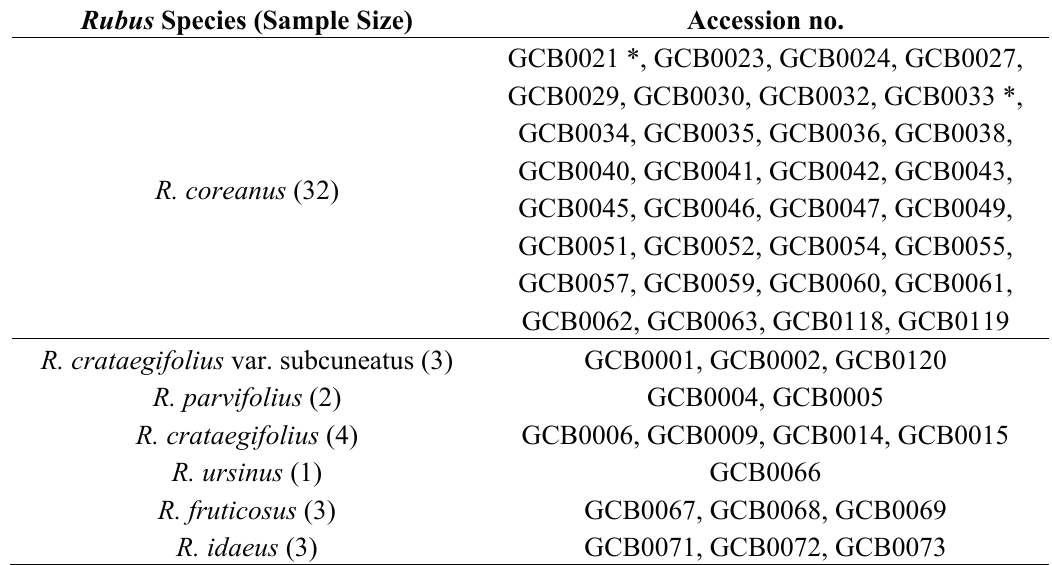
Table 1. List of accessions belonging to the Rubus genus.